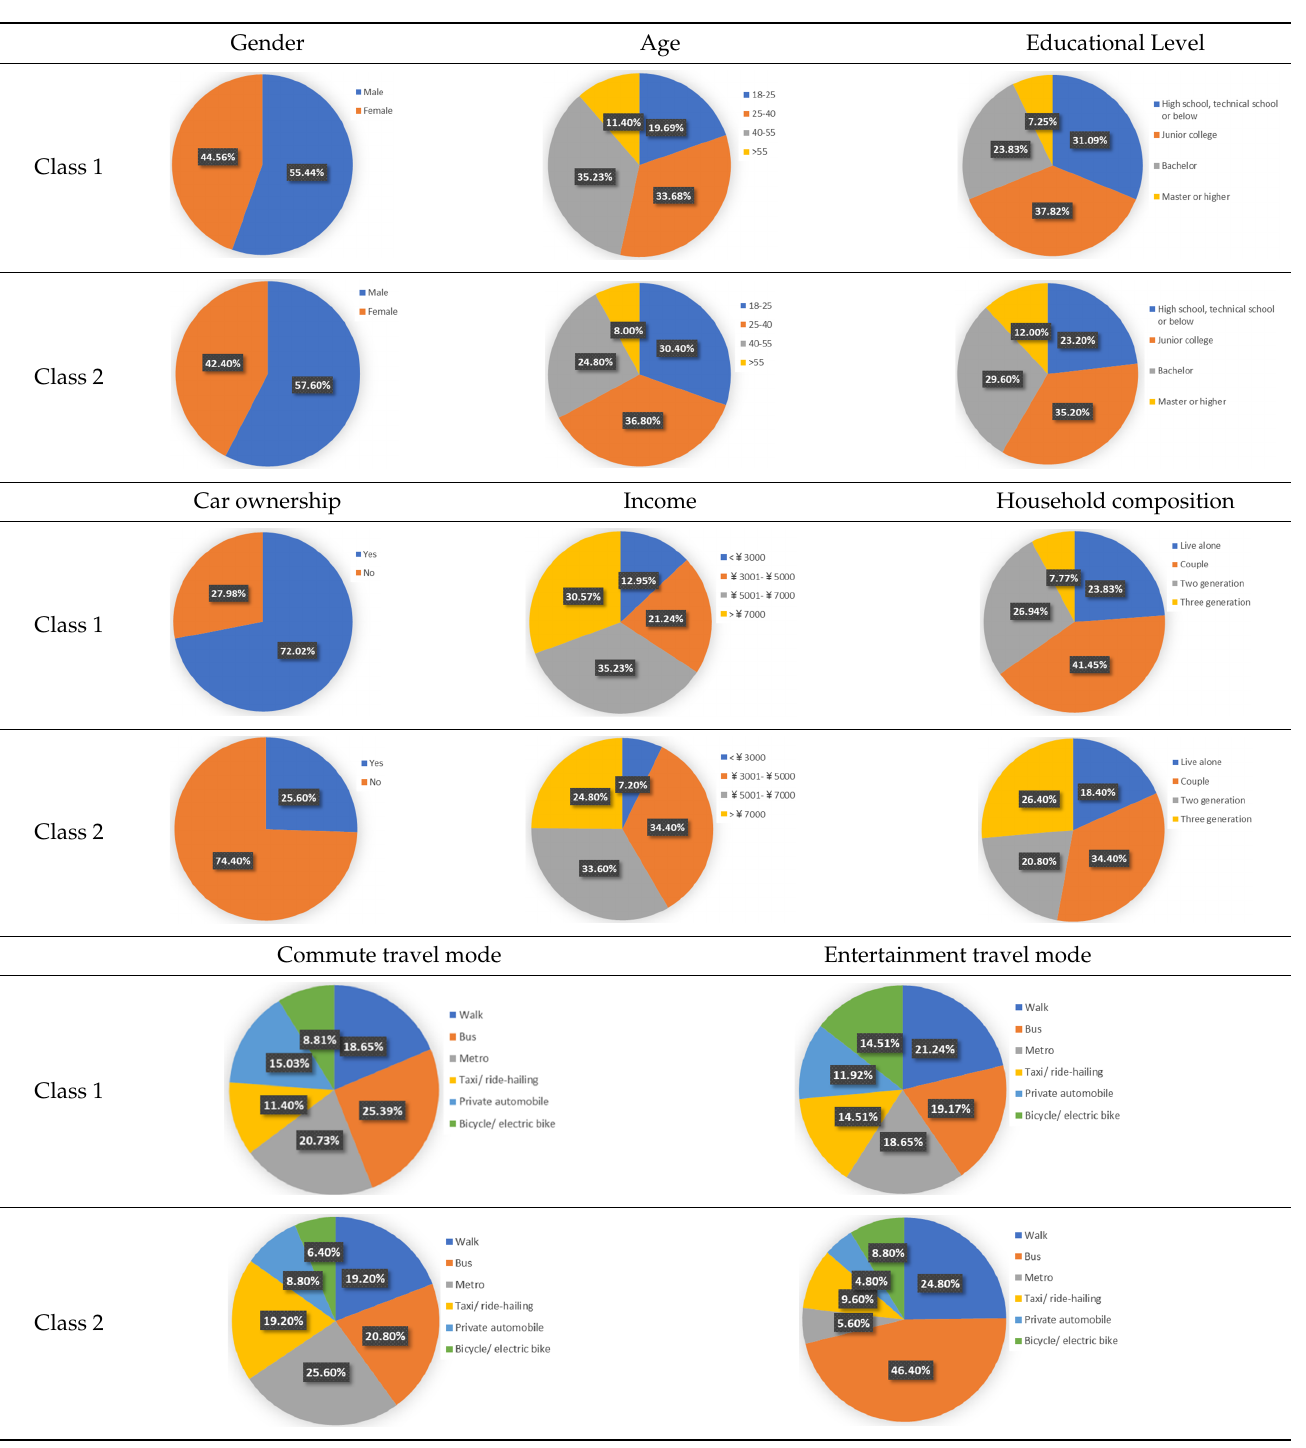
Table 6. Characteristics of each class in Wave